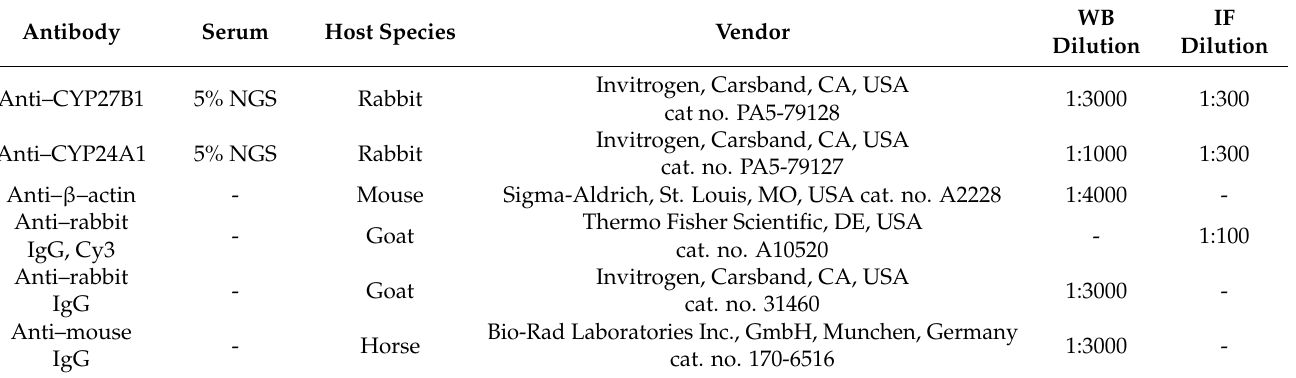
Table 1. Primary and secondary antibodies used for Western blot (WB) and immunofluorescence